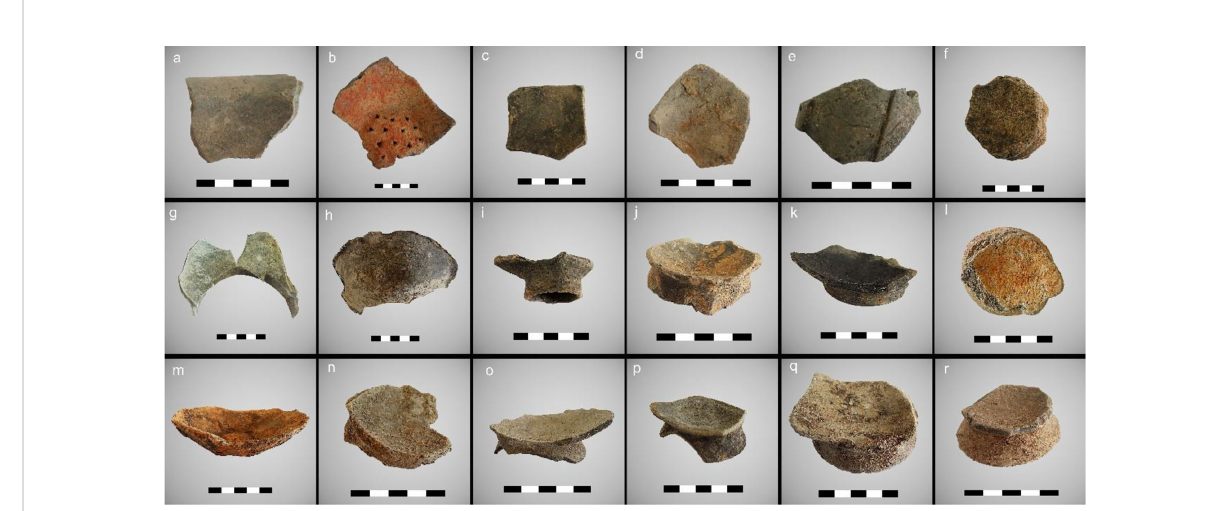
FIGURE 3 Examples of the analyzed pottery samples from the site of Qujialing ( A-F are pottery sherds dated to the Youziling Culture period; G-L are pottery sherds dated to the Qujialing Culture period; m-r are pottery sherds dated to the Shijiahe Culture period; scale bar: 10cm A : 2016HQQTN11W30 ④ : S26, B : 2016HQQTN10W30 ④ : S15, C : 2016HQQTN10W30 ④ : S12, D : 2016HQQTN11W30 ④ : S27, E : 2016HQQTN10W30 ④ : S10, F : 2016HQQTN10W30 ④ : S9); G-L are pottery sherds dated to the Qujialing Culture period ( G : 2017HQQTN49W03::S32-34, H : 2017HQQTN49W03::S94, I : 2016HQQTN10W30::S4, J : 2016HQQ ash pit, 2 ⑤ :S155, K : 2016HQQ ash pit, 2 ⑤ :S144, L : 2016HQQTN13W30::S40); M-R are pottery sherds dated to the Shijiahe Culture period) ( M : 2016HQQTG8:: S75, N : 2016HQQTG8:: S76, O : 2016HQQTN25W41:S66, P : 2016HQQTN25W41:S63, Q : 2016HQQTN25W41:S62, R :